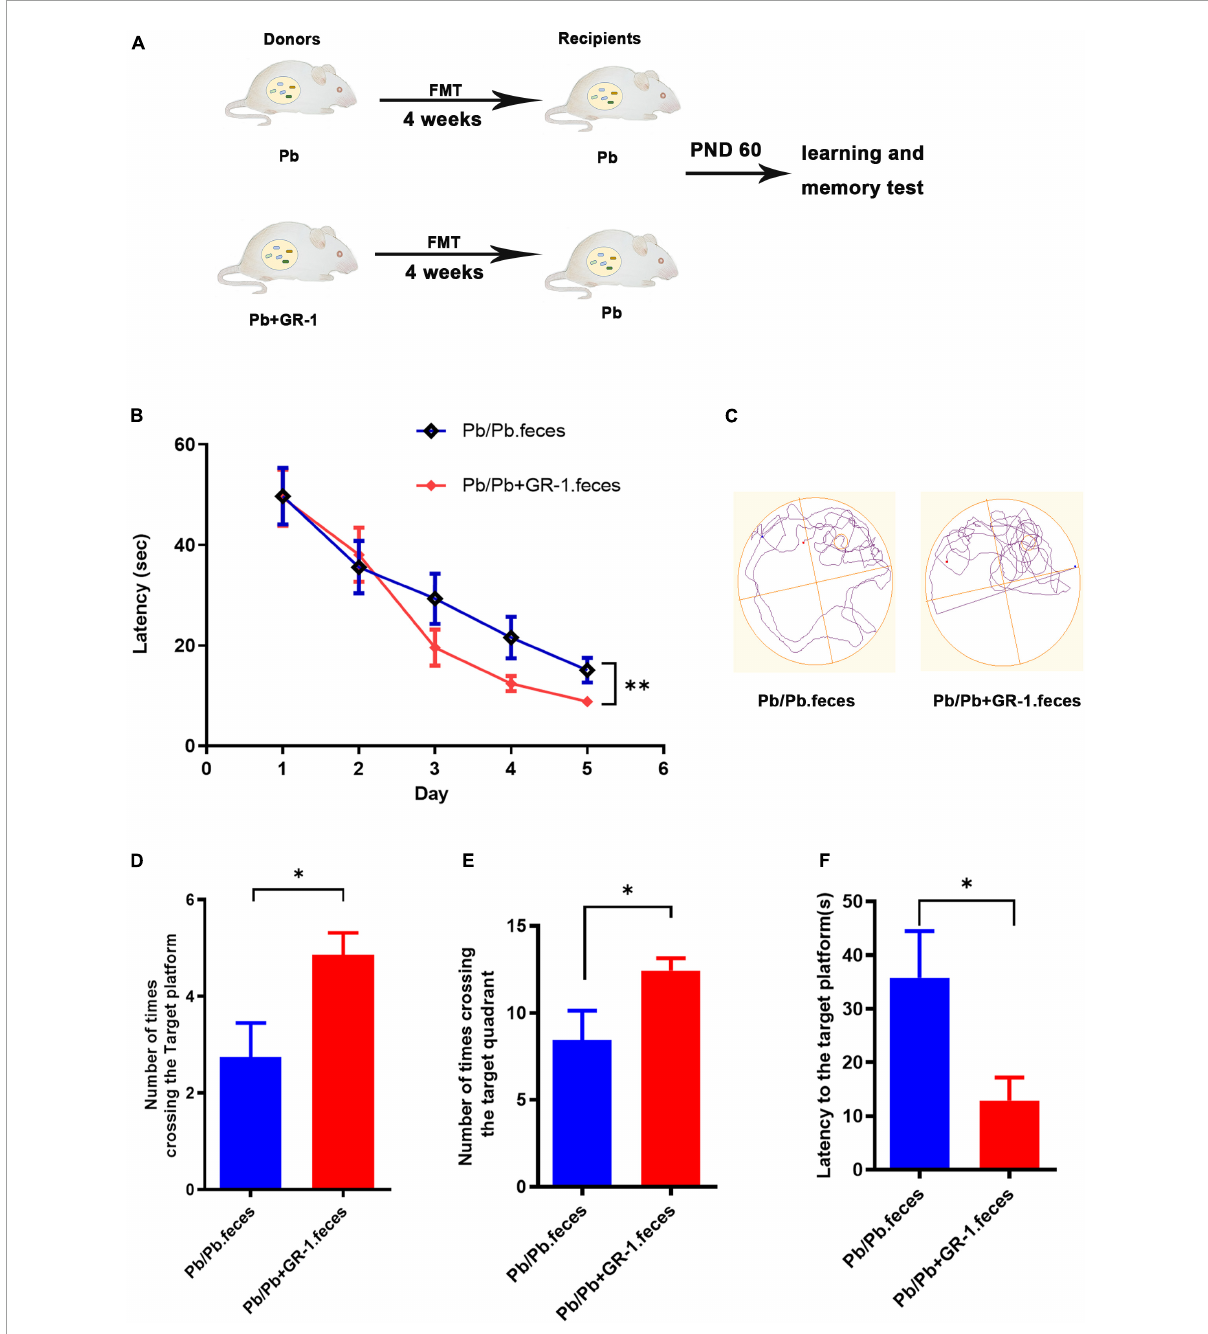
FIGURE4 Reshaping gut microbiota with Pb + GR-1 feces repaired the Pb-induced learning and memory deficits. (A) Scheme of fecal microbiota transplantation (FMT) assay. (B) The escape latencies of MWM test over five consecutive training days. n = 8. (C) Representative swimming paths of indicated groups during the test day. (D–F) The average crossing number over the platform site (D) , the number of times crossing the target quadrant (E) , and the latency of the first target-site crossover during the test day (F) . n = 8. Data are shown as mean ± SEM. ∗ p < 0.05, ∗∗ p <